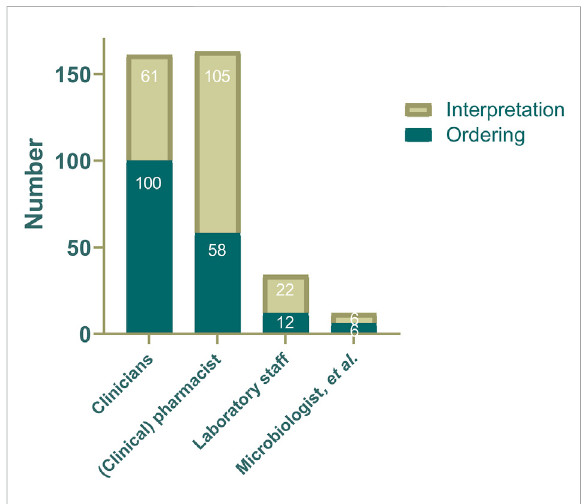
FIGURE 2 The distribution of professionals responsible for ordering or interpretation anti-infective agents TDM service ateach institution (N =